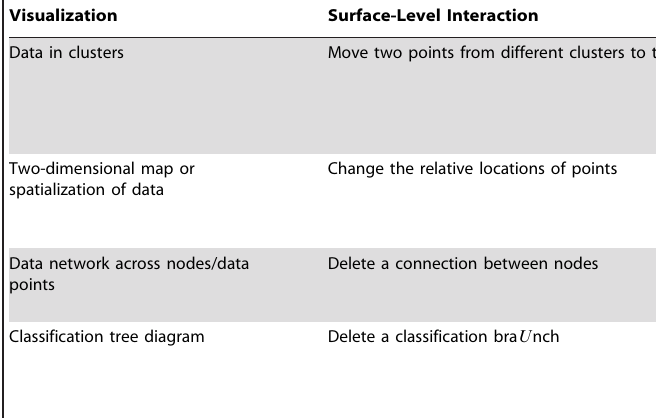
Table 2. A non-exhaustive list of V2PI.